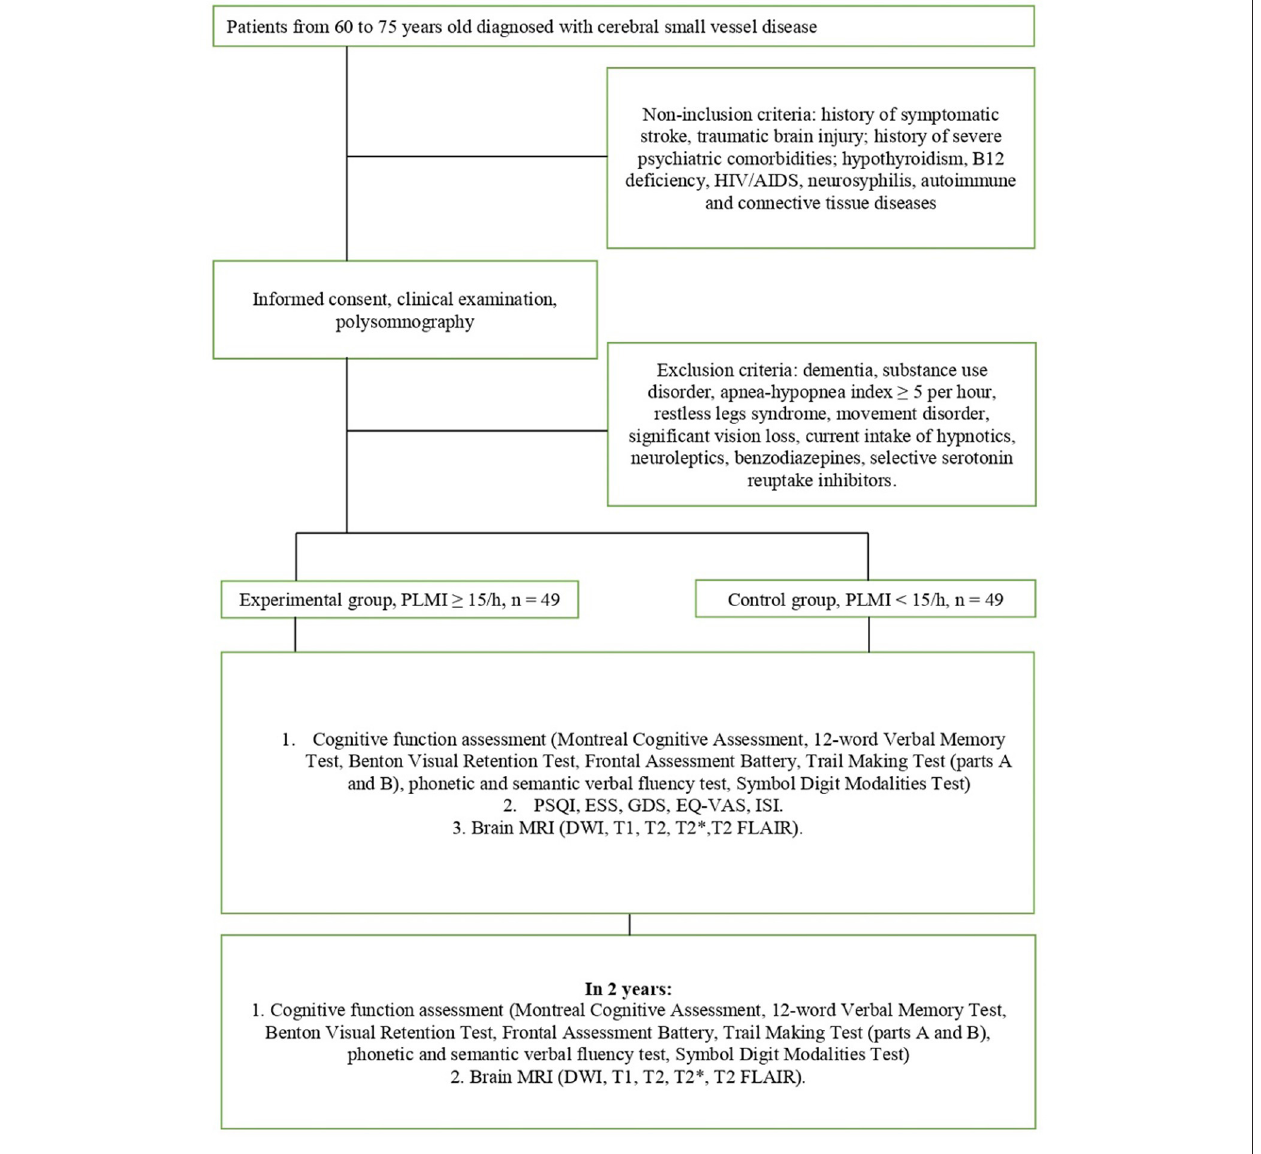
FIGURE 1 | Design of the